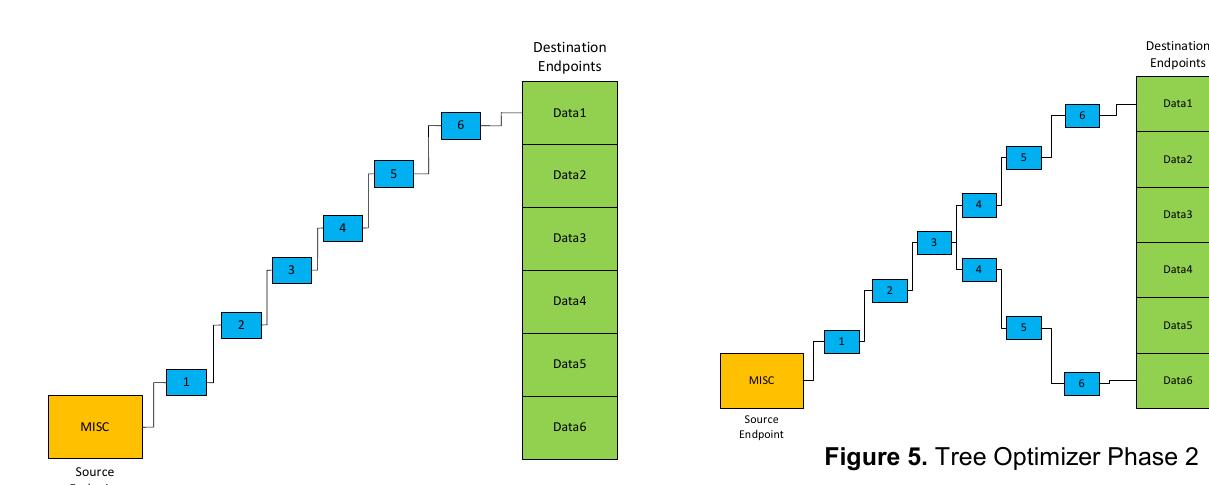
Figure 6. Tree Optimizer Phase 3 Output